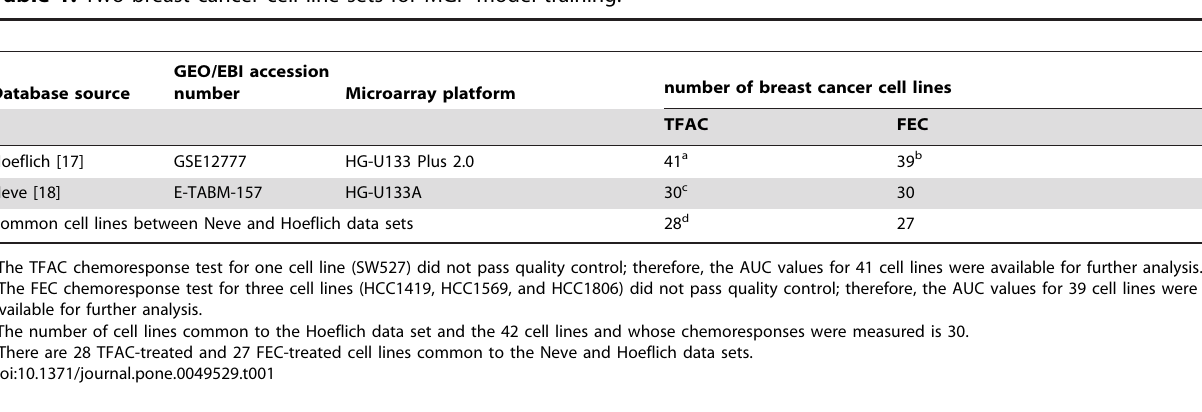
Table 1. Two breast cancer cell line sets for MGP model training.